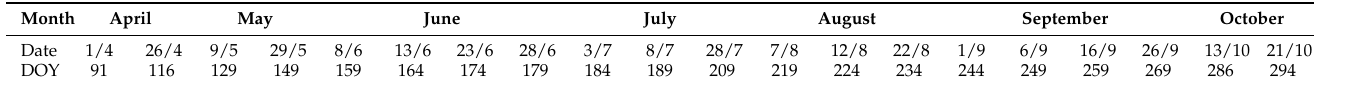
Table 2. Temporal resolution of Sentinel-2 images of year 2019 (DOY: day of